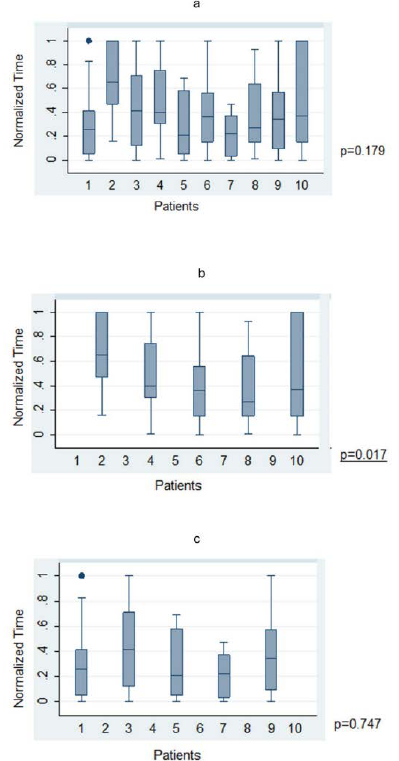
Figure 3. Trajectory planning time—Trajectory-based nBx (T-nBx) vs. Anatomy-based nBx group (A-nBx)-box-plot analysis; ( a ) Trajectory planning time from exercise 1 to exercise 10 for entire cohort; ( b ) Trajectory planning time from exercise 1 to exercise 10 for A-nBx group; ( c ) Trajectory planning time from exercise 1 to exercise 10 for T-nBx group box plot